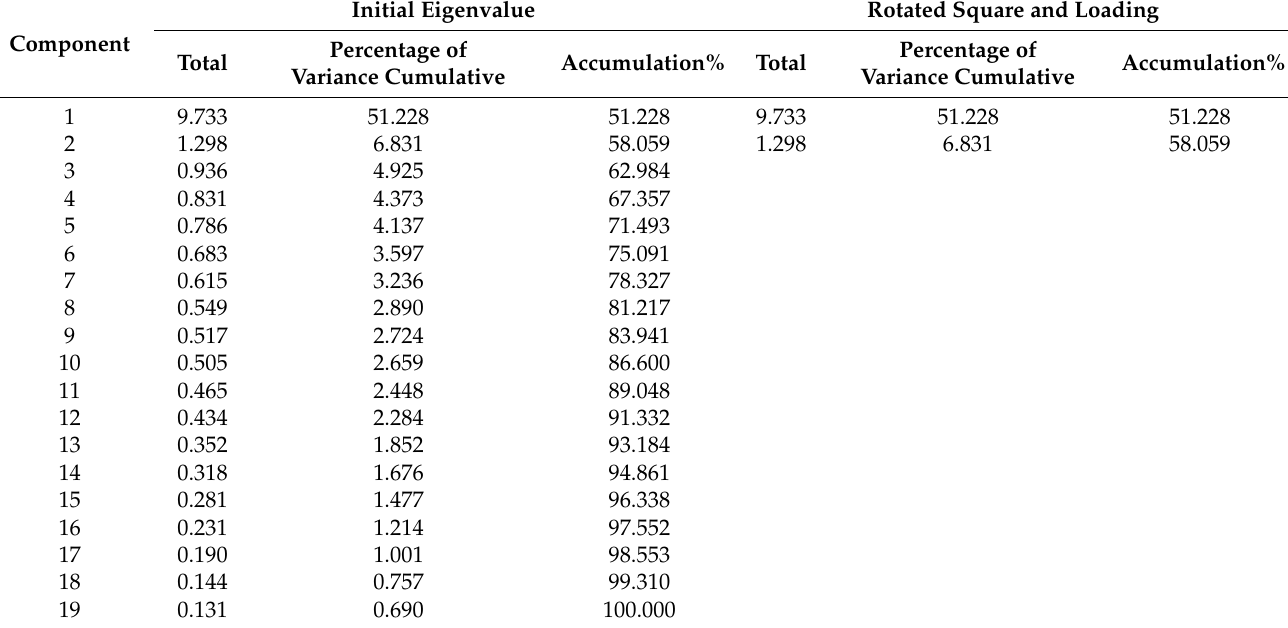
Table 4. Total variance